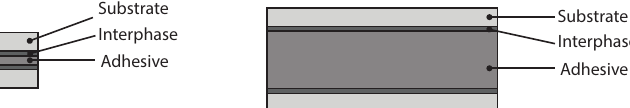
Figure 1. Different adhesive thicknesses to isolate the effect of the interphase, thin ( left ) and thick ( right